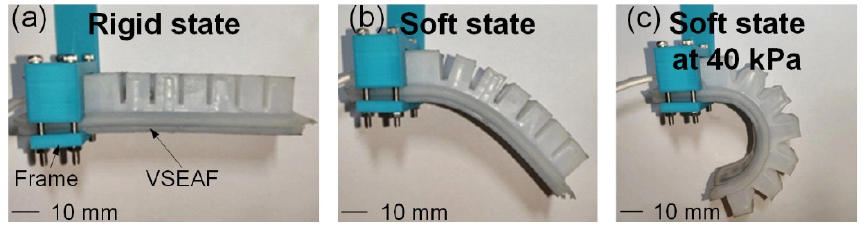
Figure 6. The VSEAF’s bent state under rigid and soft states: ( a ) the VSEAF in a rigid state, ( b ) the VSEAF in a soft state, and ( c ) the VSEAF in a soft state under 40 kPa. The VSEAF stiffness predominantly occurs in two states: the rigid state for low melting point alloys in solid form and the soft state for low melting point alloys in liquid form.